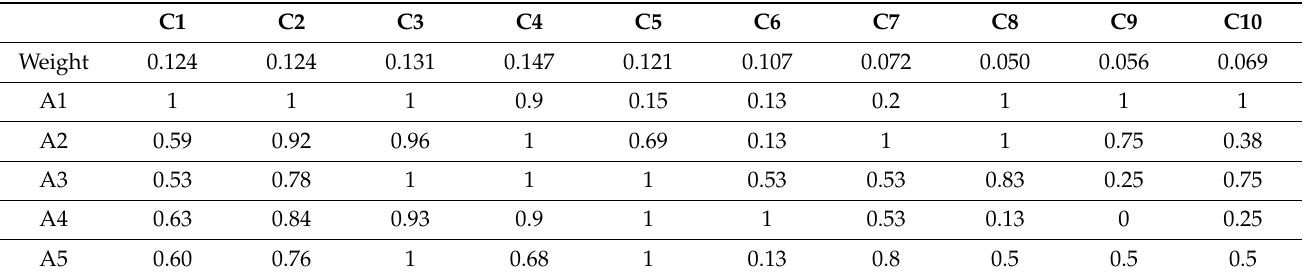
Table 14. Normalized decision-making